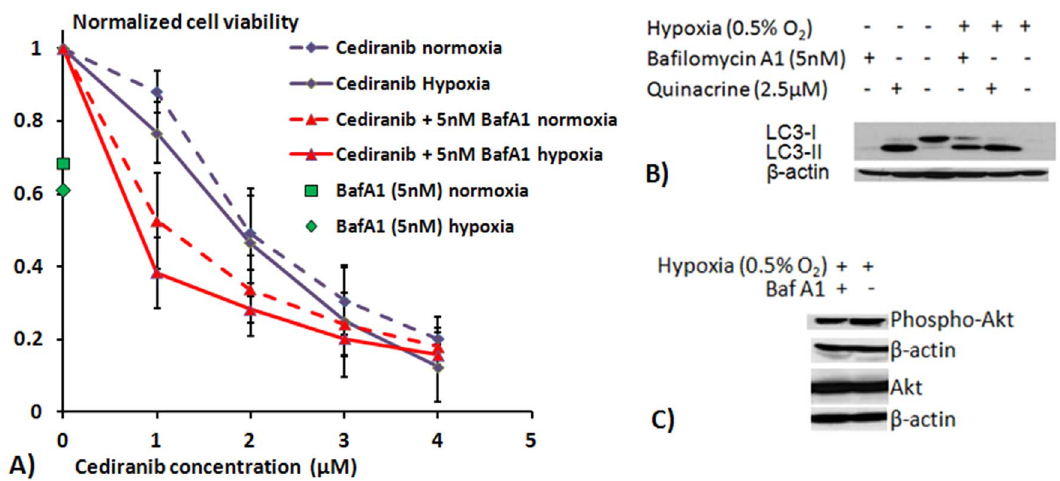
Fig. 5. Bafilomycin A1/cediranib efficacy and bafilomycin A1 effects on LC3 and Akt. A) Results from MTS cell viability assays showing mean 4C8 cell viability in response to treatment, normalized to untreated samples. Assays were performed after cells were exposed to cediranib and/or bafilomycin A1 treatment for 72 hours, under normoxic or hypoxic (0.5% O 2 ) conditions. Results are mean ¡ SEM of three independent experiments, performed in triplicate. B) Representative LC3 western blots obtained from 4C8 cells grown under normoxic or hypoxic (0.5% O 2 ) conditions for 10 hrs while untreated or exposed to quinacrine (0.8 m M) or bafilomycin A1 (5 nM). C) Representative basal Akt and phospho-Akt western blots obtained from 4C8 cells grown under hypoxic (0.5% O 2 ) conditions for 24 hrs while untreated or exposed to bafilomycin A1 (5